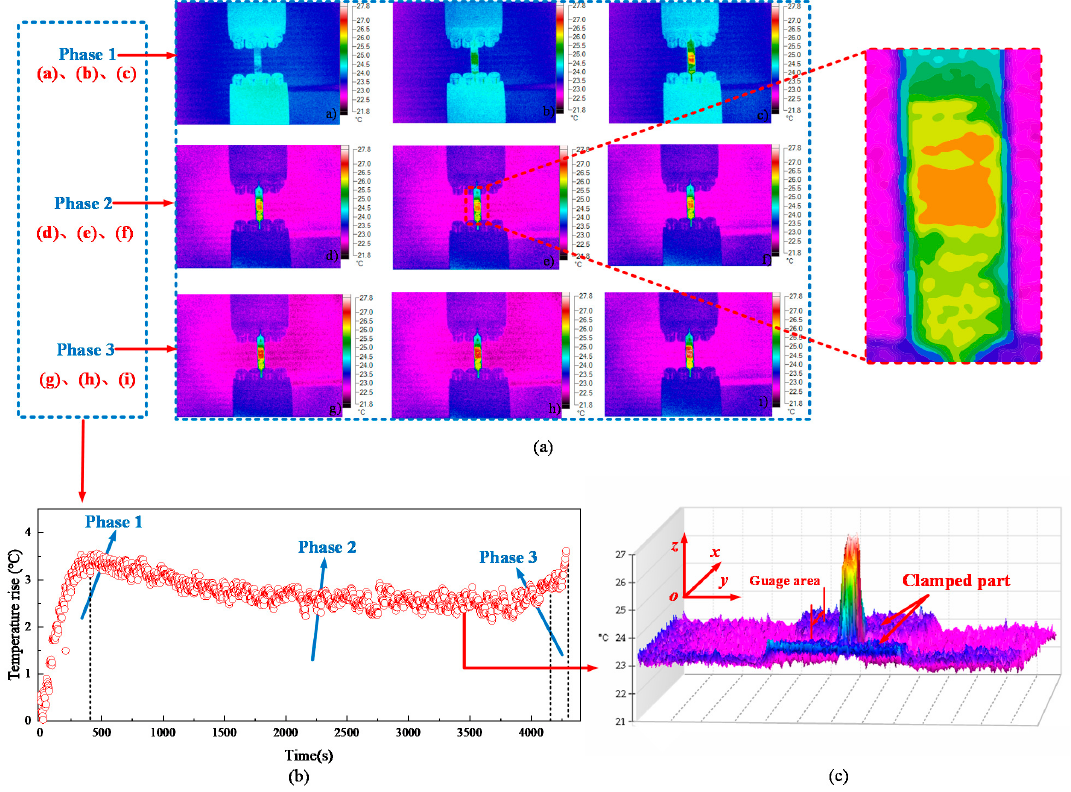
Figure 7. Infrared images and the three-stage fatigue temperature increase of the specimen at an amplitude of 148.5 MPa. ( a ) Typical thermal images; ( b ) three-stage fatigue evolution; ( c ) 3D temperature profile.